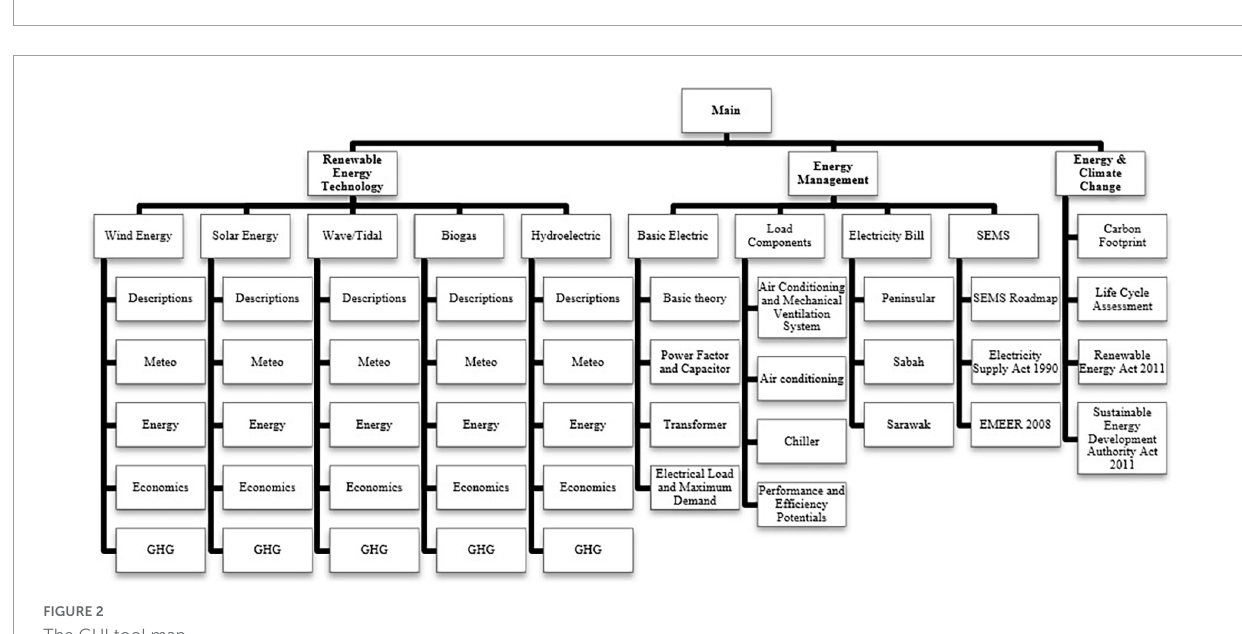
FIGURE1 The main screen of the graphical user interface (GUI) panel.